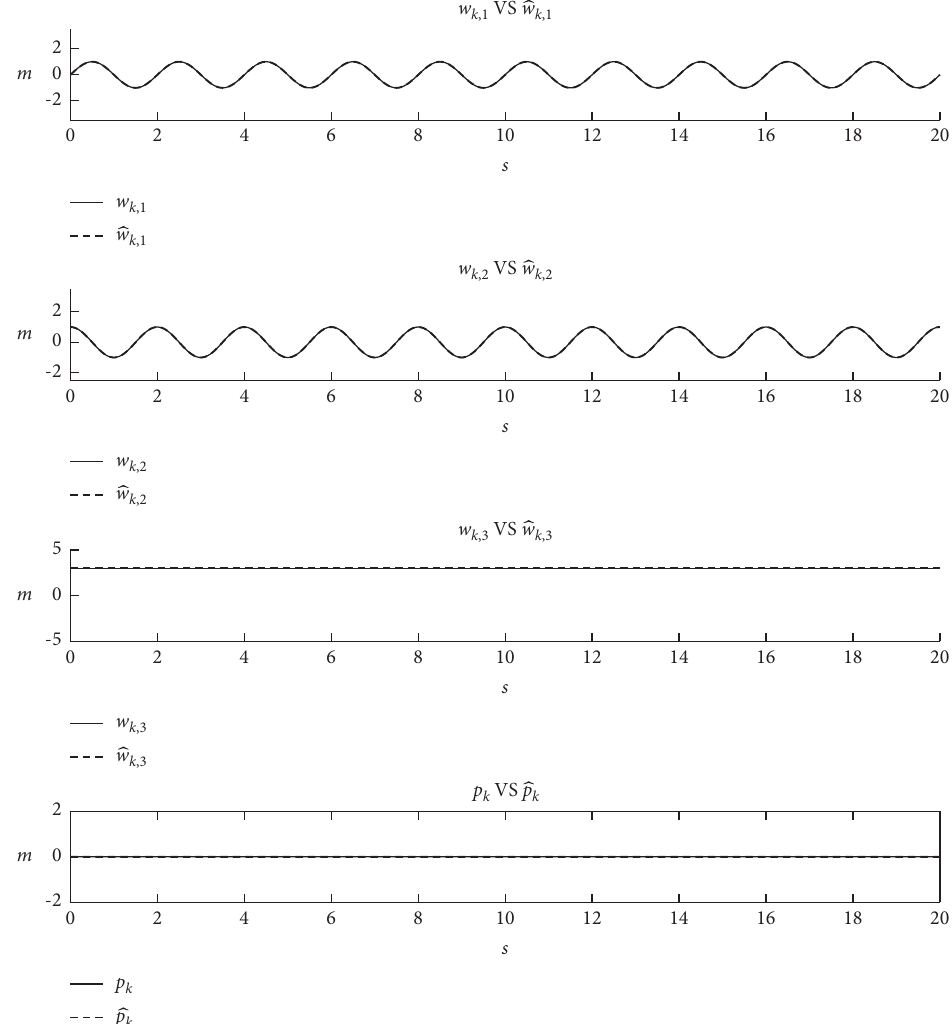
Figure 5: Estimation of references and perturbation with minimum randomness.